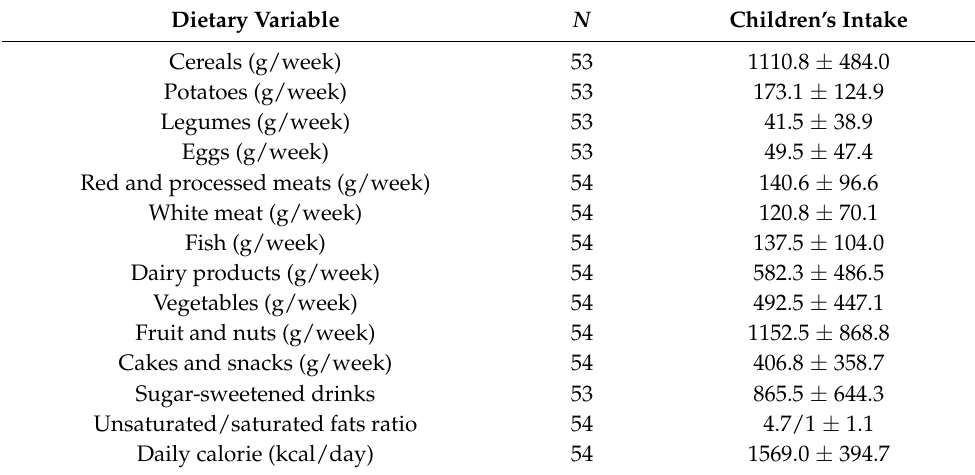
Table 2. Children’s weekly food groups and daily energy and nutrients